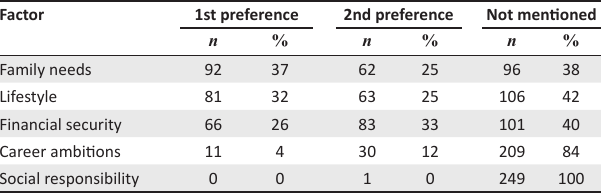
TABLE 9: Importance of factors affecting employees’ reward